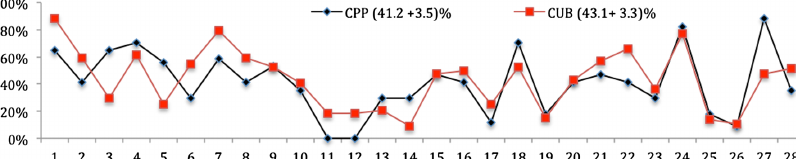
FIG. 2. Item difficulty distribution for questions from two implementations of the alpha version. In plotting this figure, we have assigned partial scores for multiple response option questions (e.g., 5, 10, 11, 12, 19, 26, and